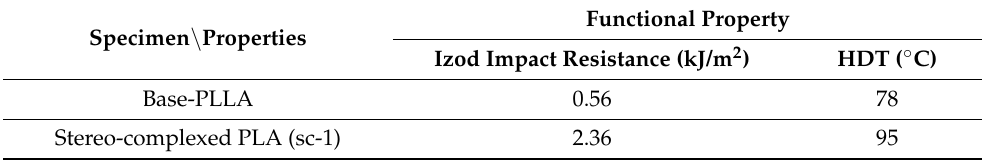
Table 8. Functional properties of base-PLLA and racemic nucleated PLA.